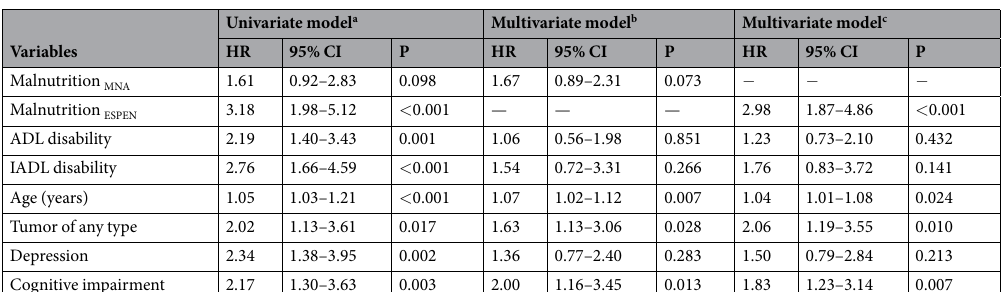
Table 2. Predictors of 3-year all-cause mortality according to Cox proportional hazard regression models. Abbreviations: CI: confidence interval; HR: hazard ratio. In Cox regression (univariate and multivariate), normal nutritional status, independence in ADL and IADL, lower age, and not having tumor of any type, depression, and cognitive impairment were used as reference categories. a Only significant variables are presented except for malnutrition. b Using malnutrition MNA as a variable. c Using malnutrition ESPEN as a